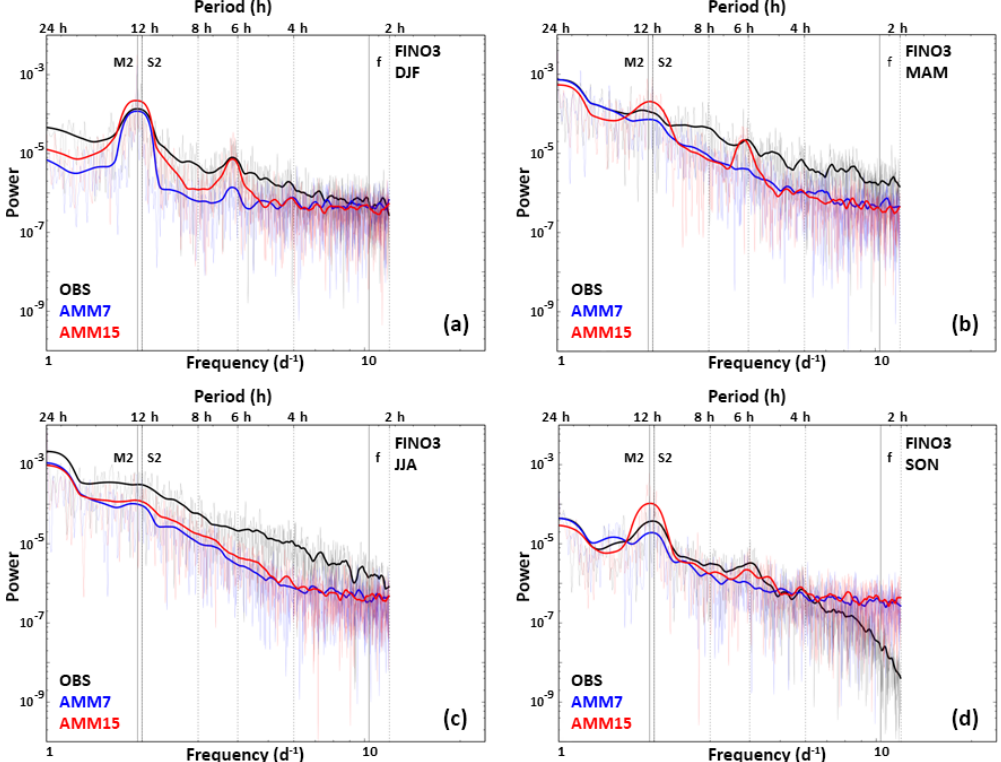
Figure 11. Power spectrum of SST for the FINO 3 buoy (black line) compared with the AMM7 (blue) and AMM15 (red) simulations for